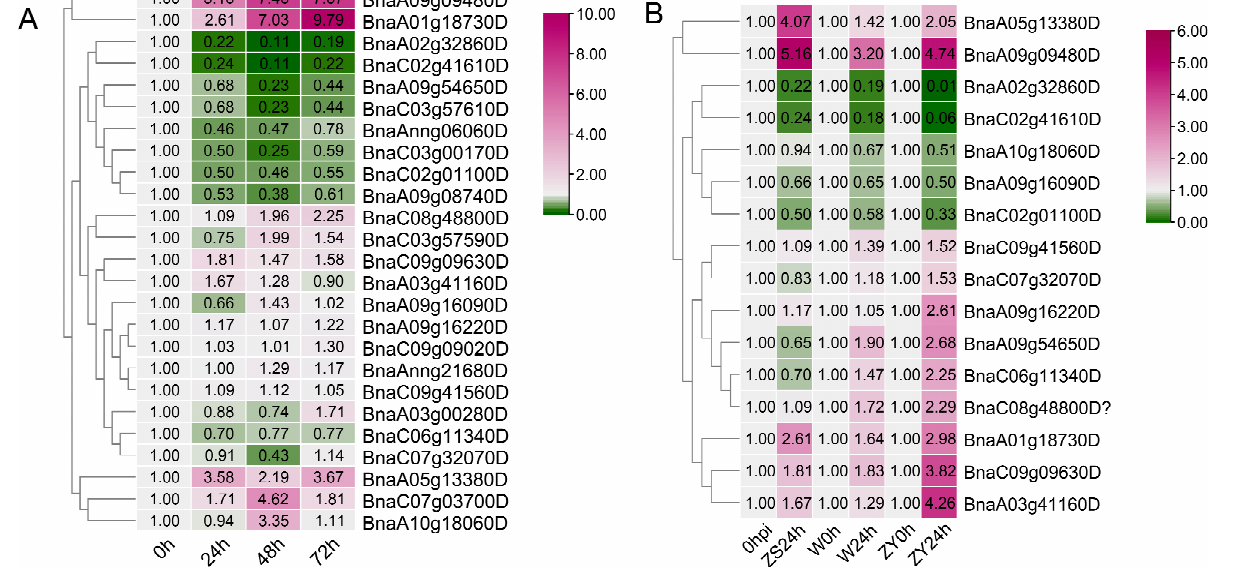
Figure 6. Gene expression heat map of GYFs in rapeseed cultivars induced by Sclerotinia sclerotiorum . ( A ) Gene expression heat map of ZHONGSHUANG11 (ZS11) infected by S. sclerotiorum at 24, 48, and 72 h post-inoculation. ( B ) Gene expression heat map of ZS11, Westar (W), and ZHONGYOU821 (ZY821) infected by S. sclerotiorum at 24 h